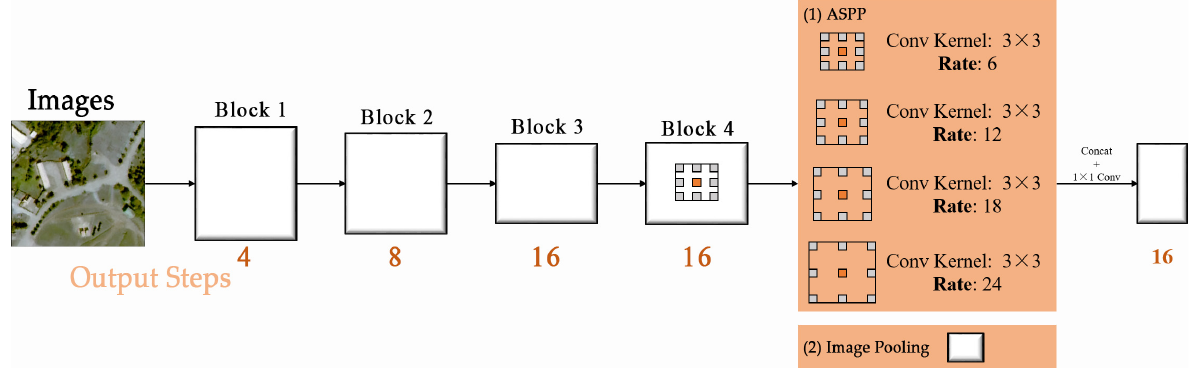
Figure 4. The structure of ASPP.